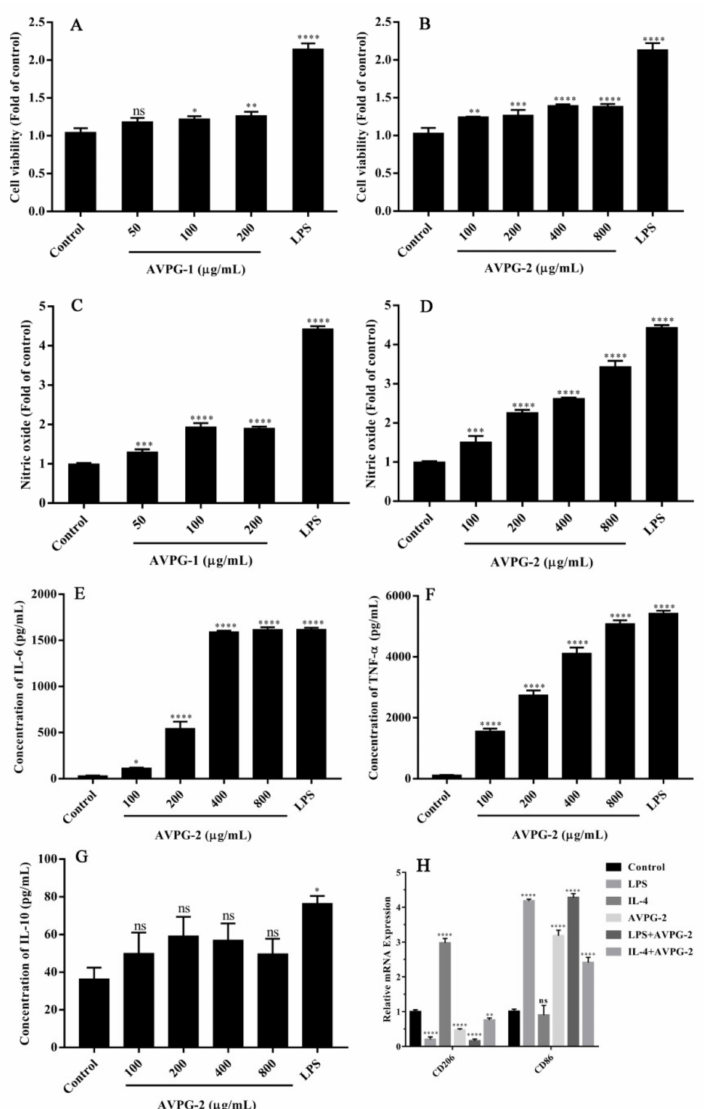
Figure 7. Effects of AVPG-1 and AVPG-2 on cell proliferation ( A , B ) and nitric oxide (NO) release ( C , D ) of RAW 264.7. Effects of AVPG-2 on interleukin (IL)-6 ( E ), tumor necrosis factor alpha (TNF- α ) ( F ) and IL-10 ( G ) production of RAW 264.7. Effects of AVPG-2 on mRNA expression of CD86 and CD206 ( H ), as determined by real time PCR (RT-PCR). Ns represents no significant difference versus control group, * p < 0.05 versus control group, ** p < 0.01 versus control group, *** p < 0.001 versus control group, **** p < 0.0001 versus control